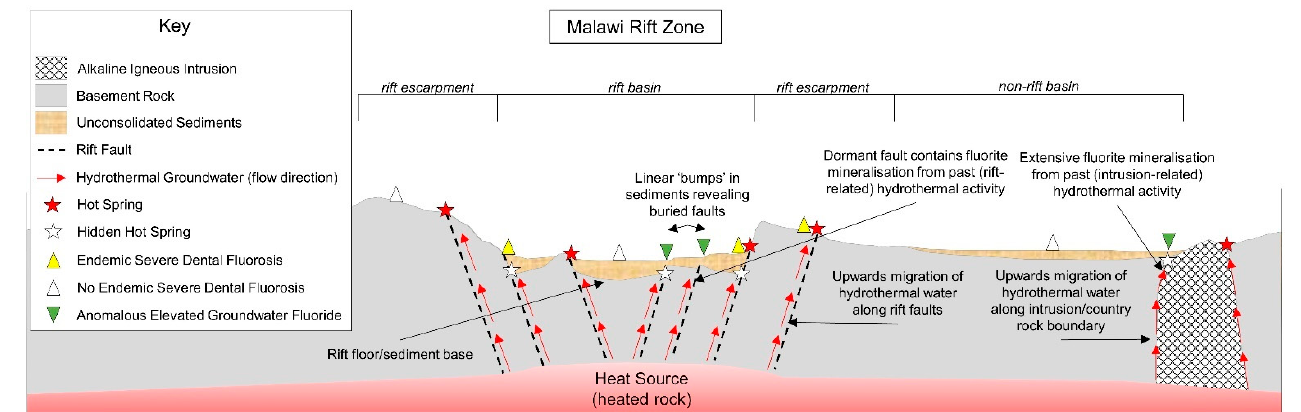
Figure 2. Schematic cross-sectional conceptual model of the study area showing mechanisms responsible for hot spring and hidden hot spring occurrences of different types. Image is intended as an idealised example and is not to scale.